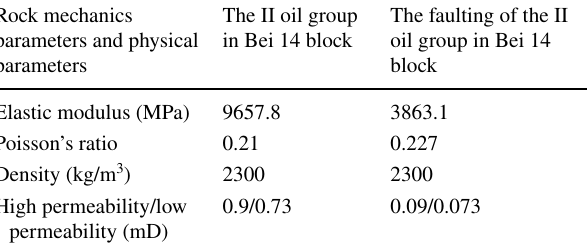
Table 1 The related parameters of Hailar Bei 14 block